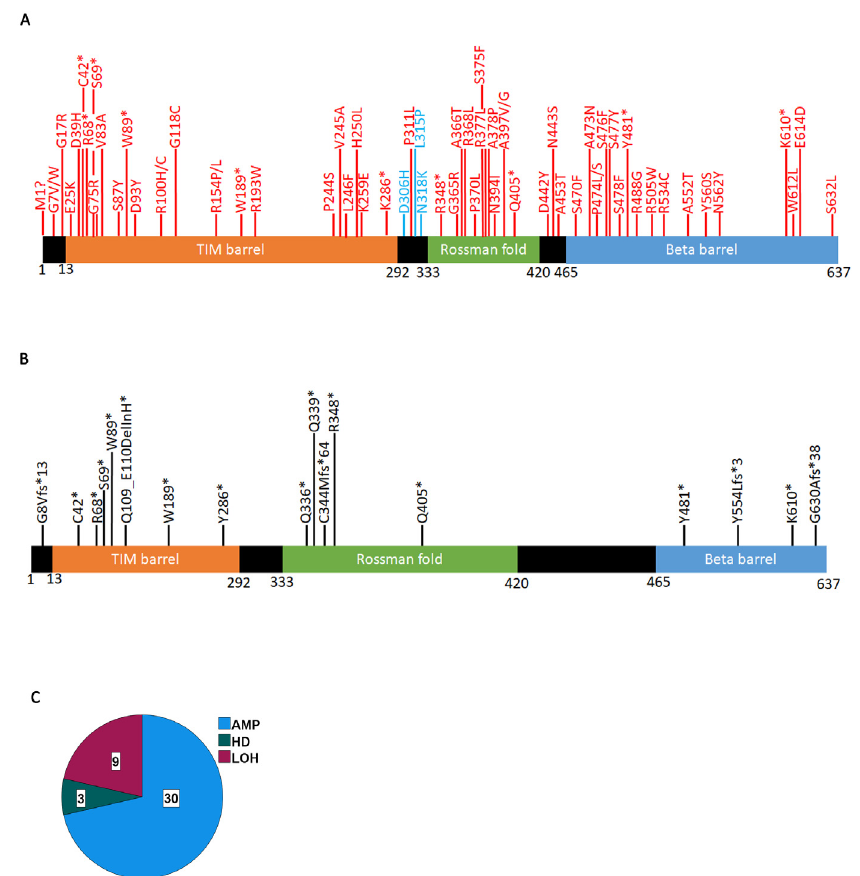
Figure 3. Significant PRMT5 mutations occurring in cancer cells. ( A ) Mutations with a significant VEST4 value (red) or significant VEST4 and CHASM values (blue) (Supplementary Table S1). ( B ) Truncating PRMT5 mutations (*) that are likely to affect the function of the gene. ( C ) PRMT5 locus structural variations. The data extracted from COSMIC using the CONNAN function.